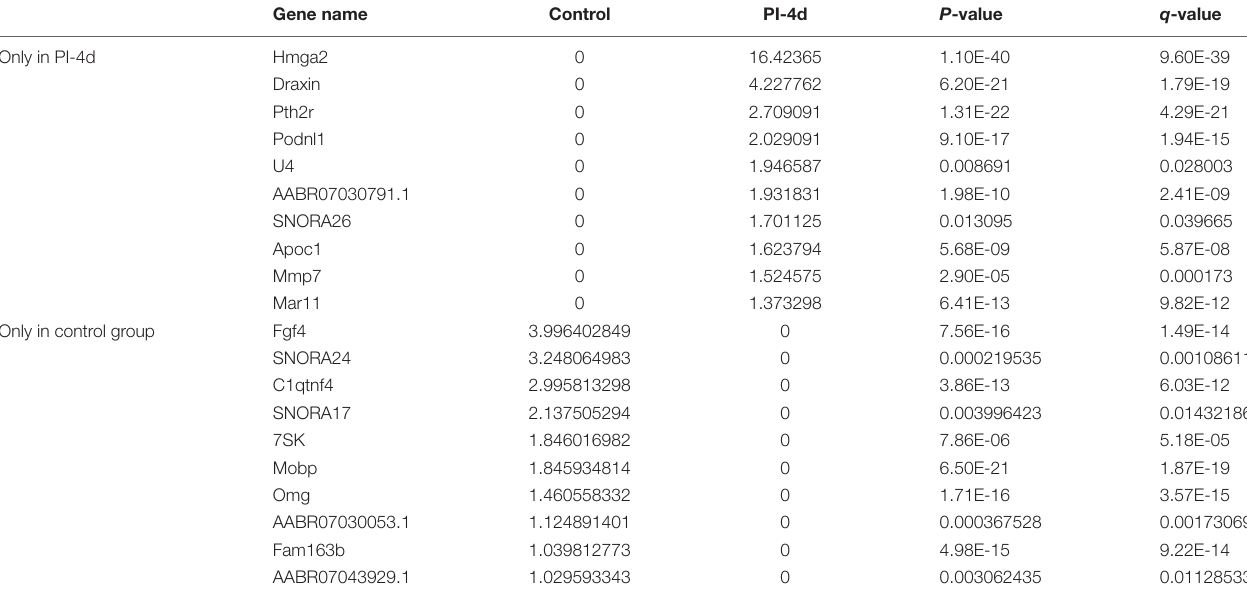
TABLE 2 | Top 10 DEmRNAs only expressed 4 days after crush injury (Post-Injury 4 days, PI-4 d) or only expressed in normal sciatic nerves.